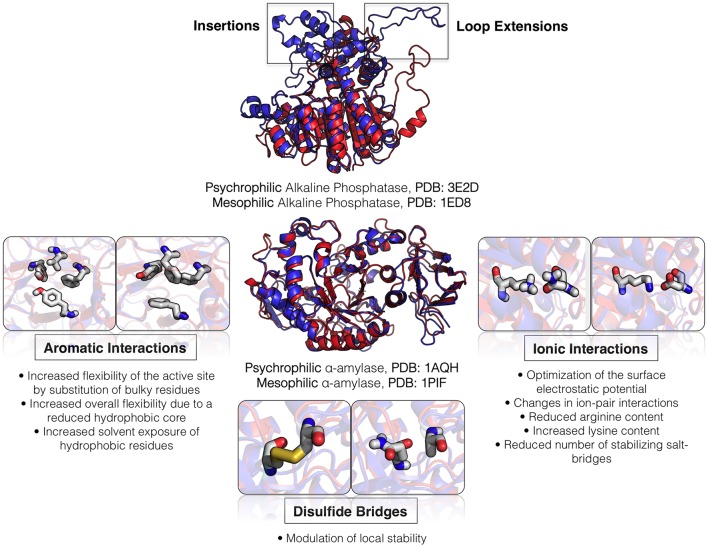
Representative scheme of the most typical modifications in cold-adapted enzymes. Psychrophilic and mesophilic alkaline phosphatases are compared to represent changes in the number of insertions and loop extensions, whereas psychrophilic and mesophilic α-amylases are used for visualizing changes in amino acid sequence related to the modification of several properties, listed below each type of amino acid changes. Modified from Helland et al. (2009) and Cipolla et al. (2011).